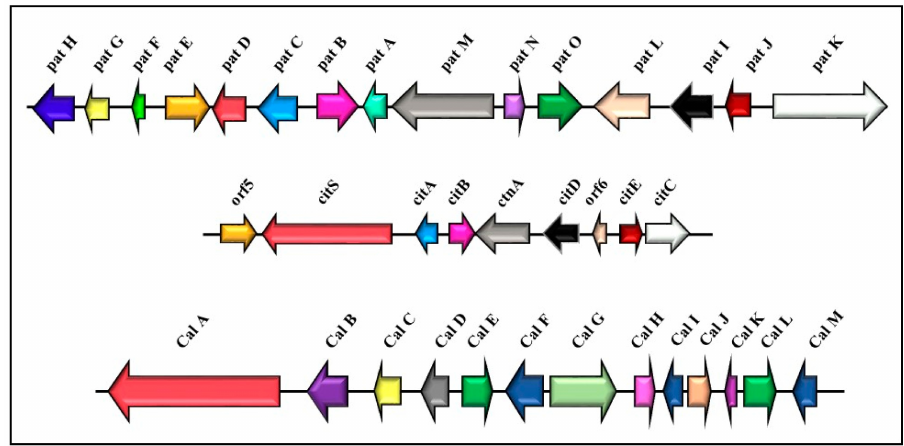
Figure 2. Gene clusters of the patulin biosynthesis pathway (the first one at the top) (15 genes, 40 kb) [39] and the citrinin biosynthesis pathway (the middle group) (nine genes, 22 kb) [40,41] in Penicillium expansum ; cluster of the calbistrin biosynthesis pathway (the third one at the bottom) (13 genes, 35kb) in Penicillium decumbens